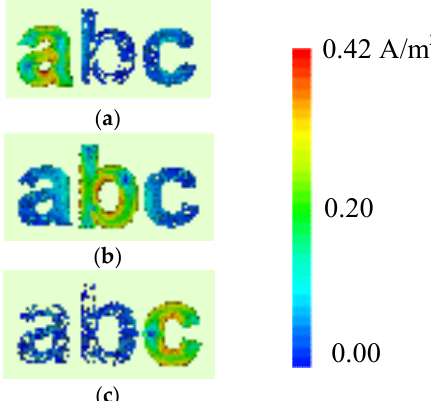
Figure 10. Cross-polar HH RCS simulation results ( a ) Letter place change effect; ( b ) Letter repetition effect.